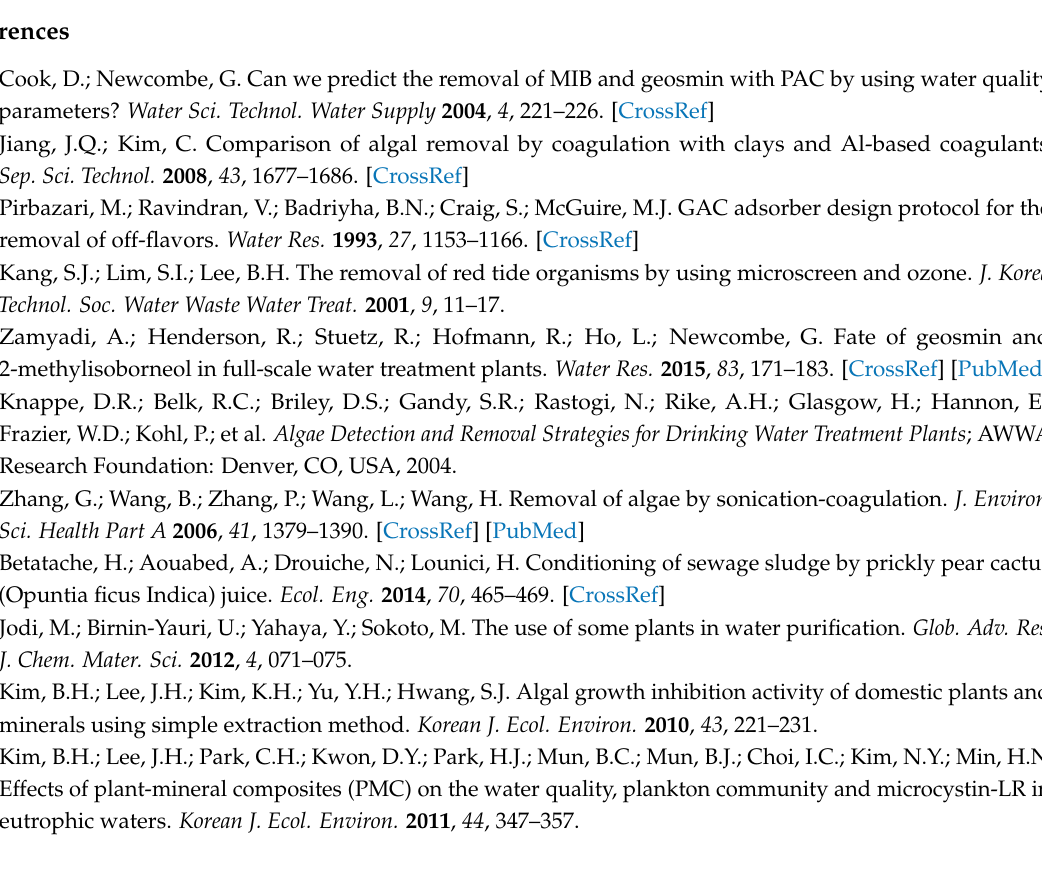
Figure S1: Determination of scavenging factor for the water sample before and after PMC treatment used in collimated beam work: R OH,UV variation with the initial H 2 O 2